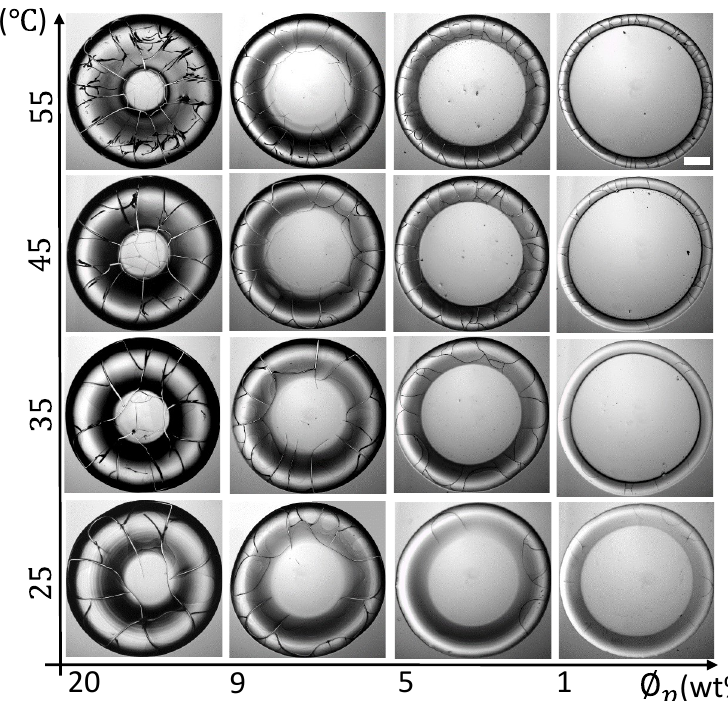
Figure 3. BSA film’s morphology during the 24 h at different initial concentrations ( φ p ) ranging from 20 to 1 wt% dried at various substrate temperatures (T) of 55, 45, 35, and 25 ◦ C. The scale bar of length 0.3 mm is represented with the white rectangle in the top-right